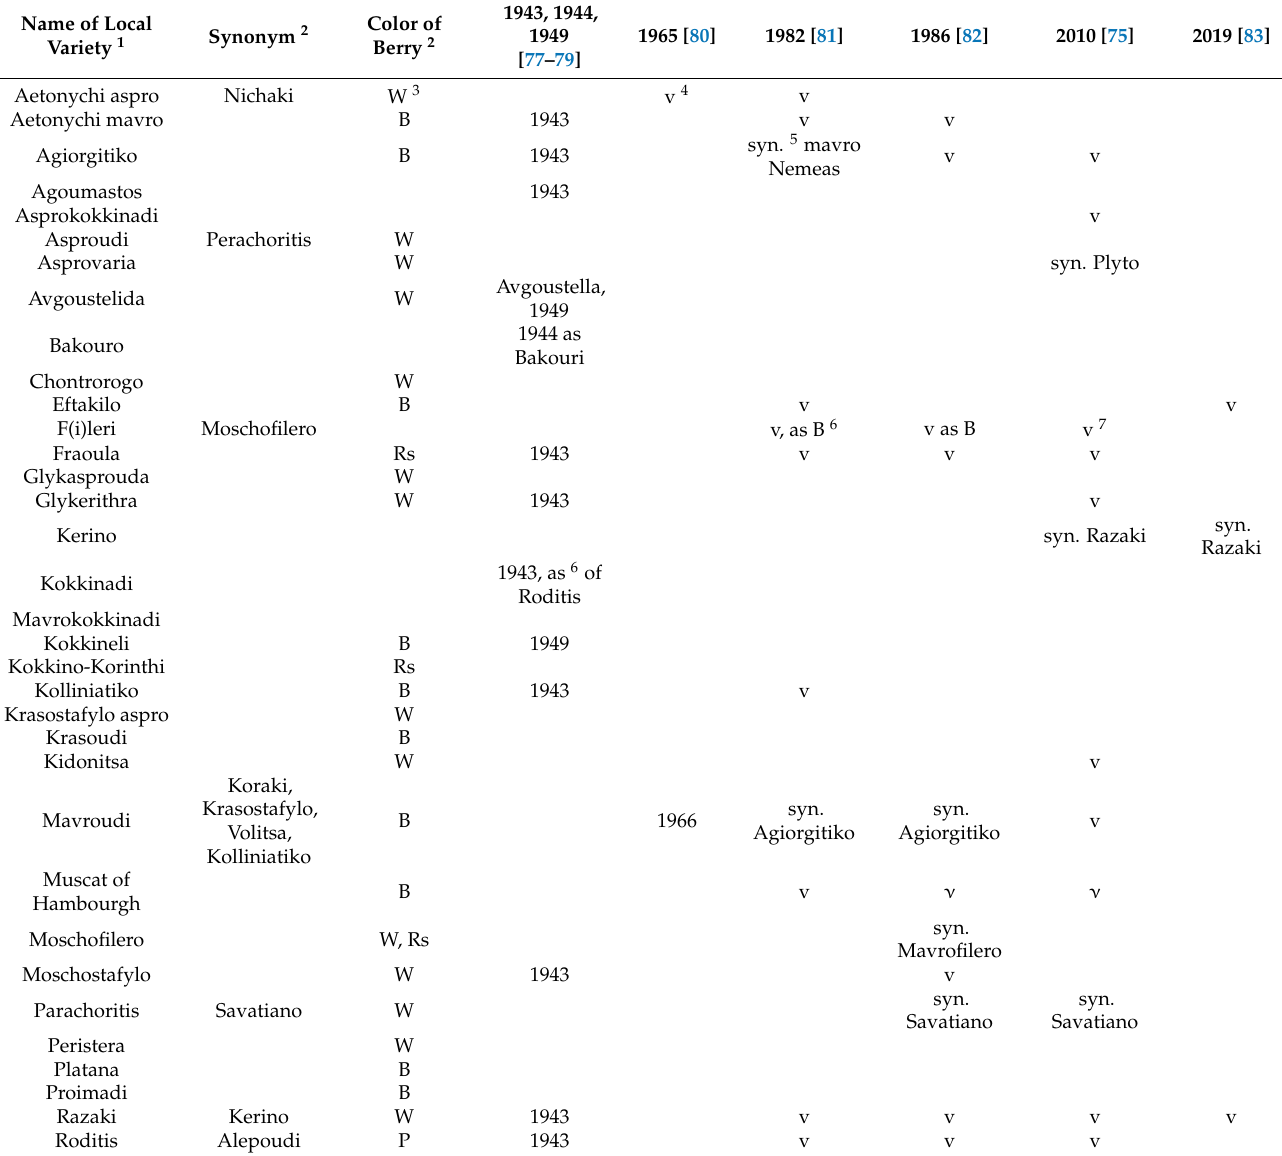
Table 5. Names of landraces of grapevine and their synonyms recorded in villages of Arcadia and literature references. Name of Local Variety